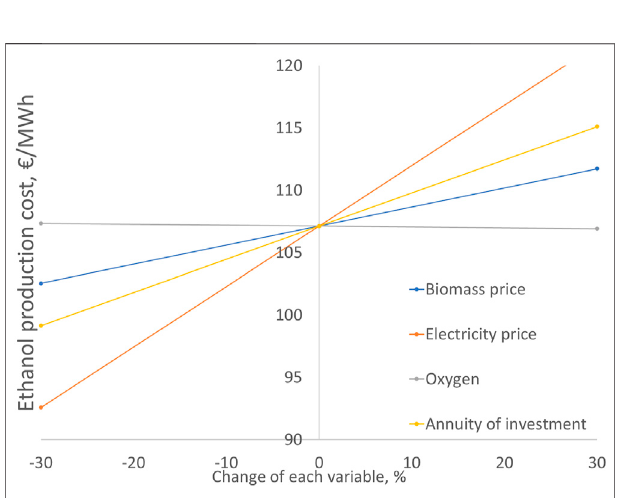
FIGURE 8 | Ethanol cost sensitivity analysis for case A. Base ethanol cost 107 € /MWh. Base parameter values: C biom = 20 € /MWh, C elec = 45 € /MWh, C € /t, annuity of investment 7.7 M € /a ( fi xed capital ox = 50 investment 78 M € ).